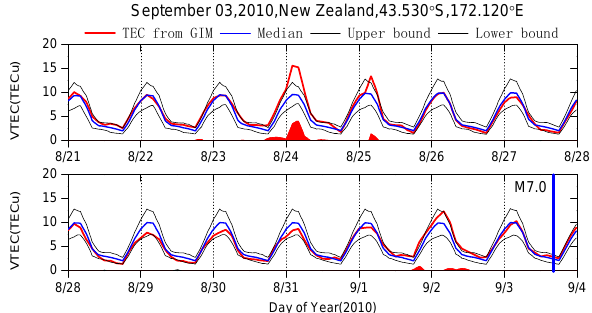
Fig. 13. VTEC time series above the New Zealand epicenter during 21 August 2010 to 3 September 2010. Symbols in this figure are the same as those in Fig.